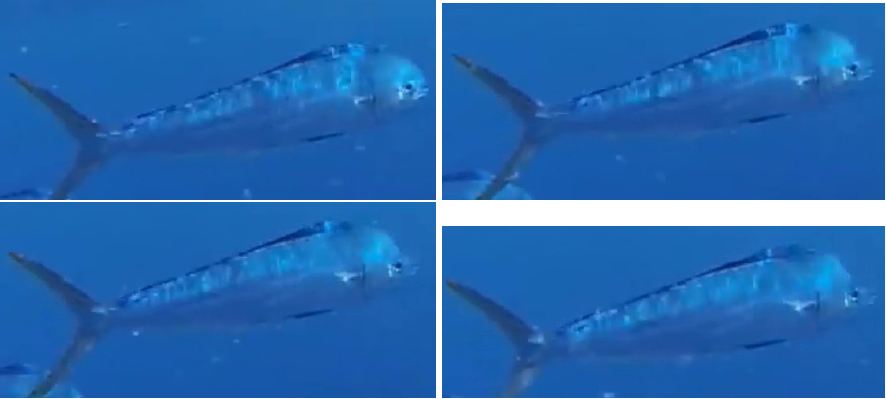
Figure 2. Images and segments from the dataset used in this paper. ( a ) Image of a Thunnus alalunga and the segment extracted from it. ( b ) Image of Seriola dumerili and segments extracted from it. Photo credit: Wikipedia.